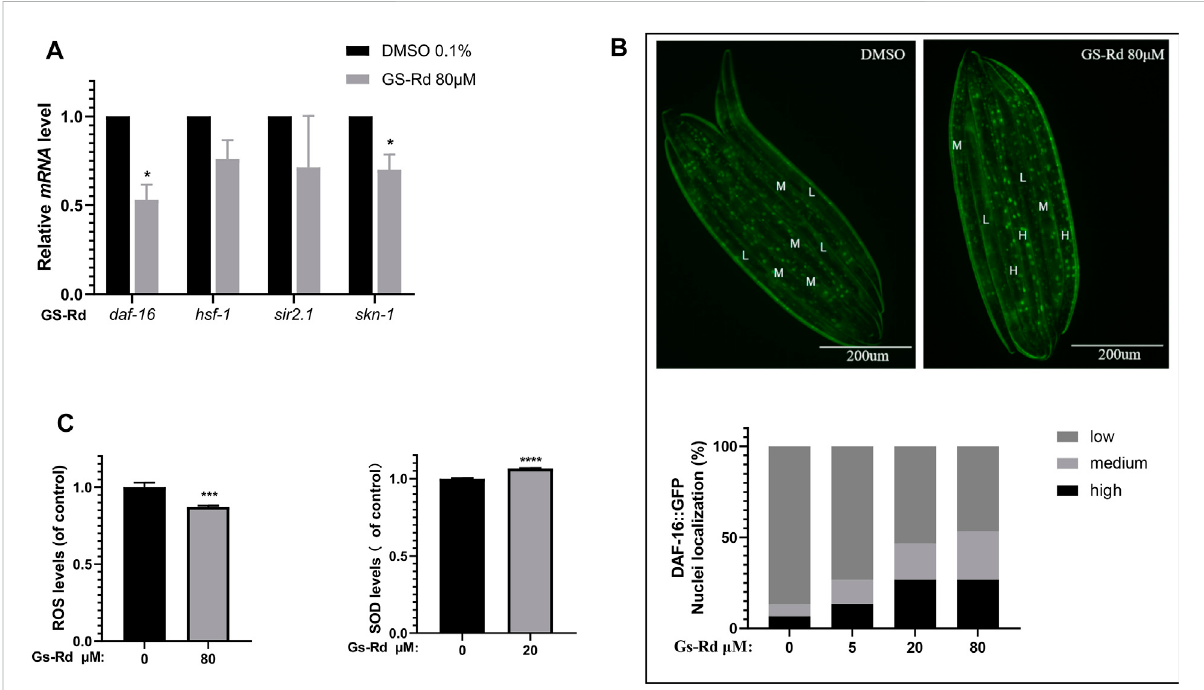
FIGURE 8 Effect of GS-Rd on oxidative stress related genes and ROS and SOD levels in (C) elegans . (A) RT-qPCR analysis of oxidative stress-related gene mRNA expression changes in GS-Rd-treated CL4176. (B) GS-Rd enhanced nuclear protein Daf-16 incorporation (C) 80 μ M of GS-Rd decreased the ROS levels and increased the activity of SOD in CL4176